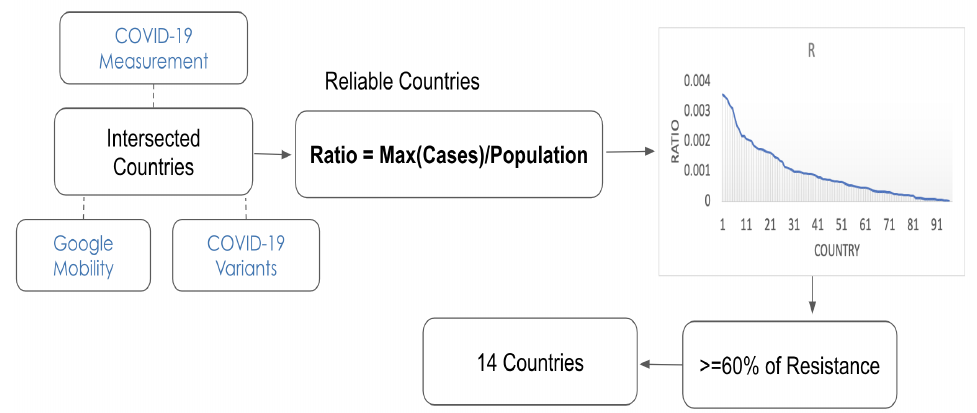
Figure 1. Flowchart of the country selection process based on the largest ratio of detected cases to the population size. Countries that exceed this threshold are included in our dataset if 60% of the population or more have acquired some form of resistance (via vaccination or prior infection) by July